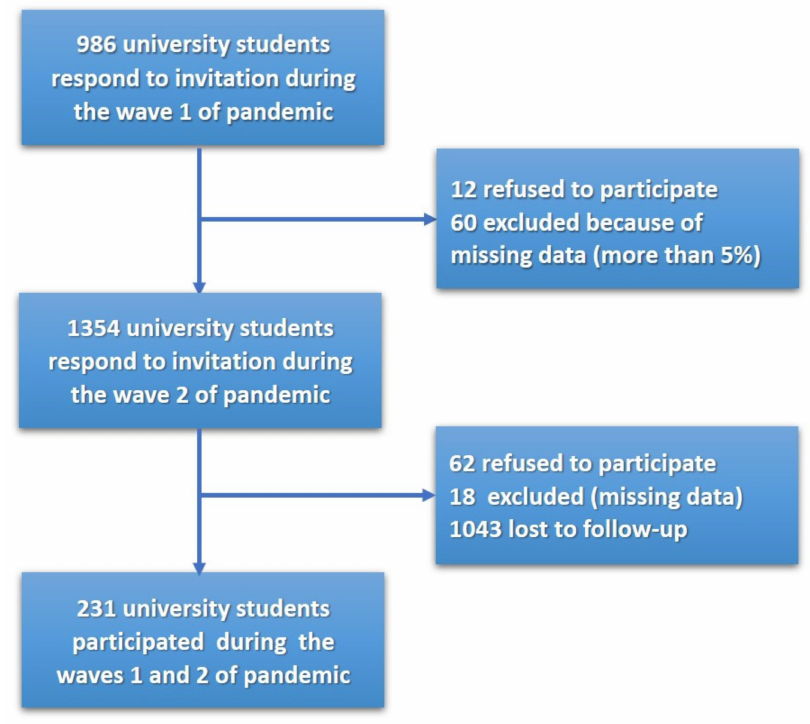
Figure 1. Flow chart of the study sample by recruitment strategy during each wave of the COVID- 19